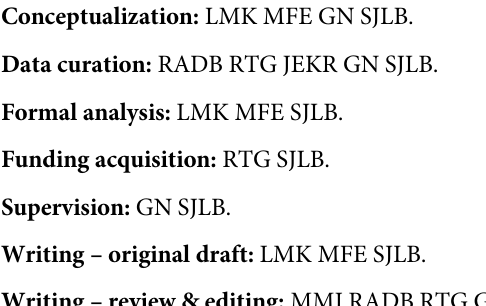
S3 Table. Association of plasma potassium with risk of developing chronic kidney disease stratified by use of diuretics in 5,130 participants of the Prevention of Renal and Vascular End-Stage Disease (PREVEND) study. Hazard ratios and 95% confidence intervals were derived from Cox proportional hazards regression models. (cid:3) Number of events divided by time at risk standardized per 10,000 person-years. † Multivariable model 1 is adjusted for age, sex, eGFR, height, weight, and urinary potassium excretion. Abbreviations: eGFR, estimated glomerular filtration rate; PREVEND, Prevention of Renal and Vascular End-Stage